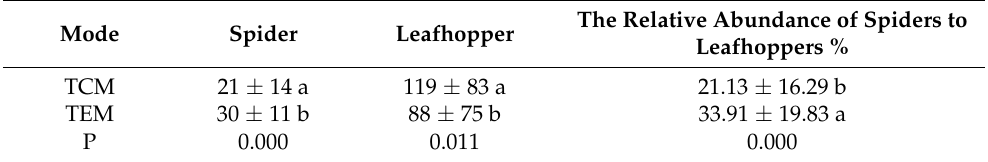
Table 1. The effects of management mode on the leafhopper pest and its enemy. Mode